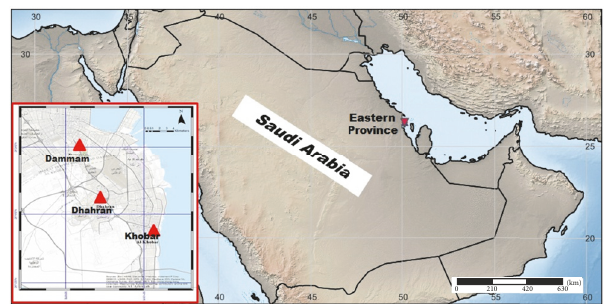
Figure 1: Map of sampling